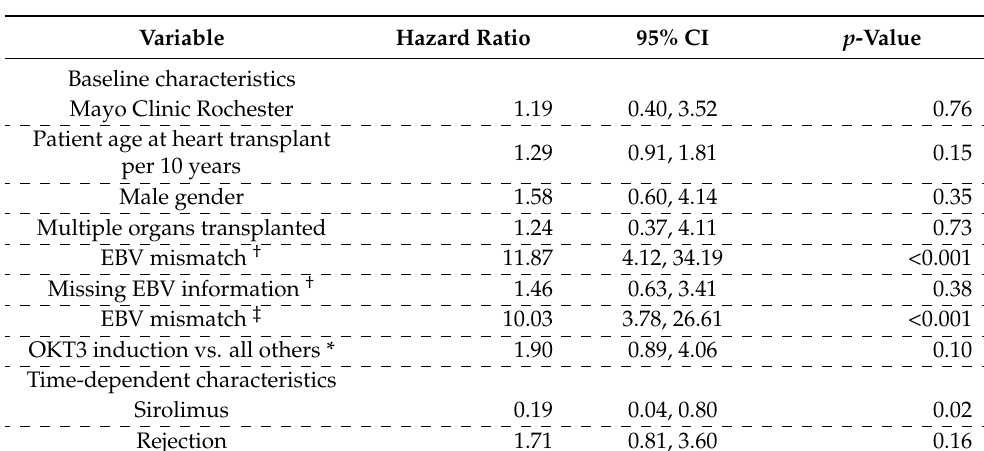
Table 2. Univariate characteristics associated with increased hazard of